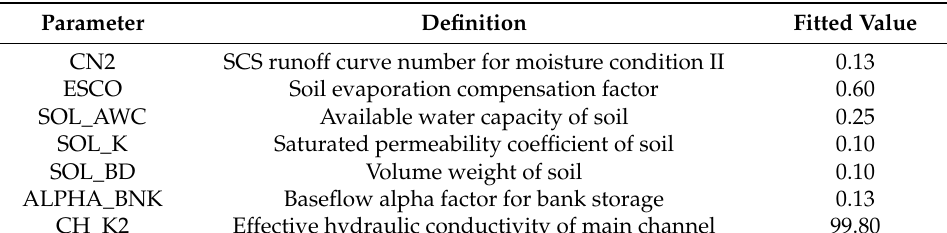
Table 4. Model parameters fitted value during calibration period.